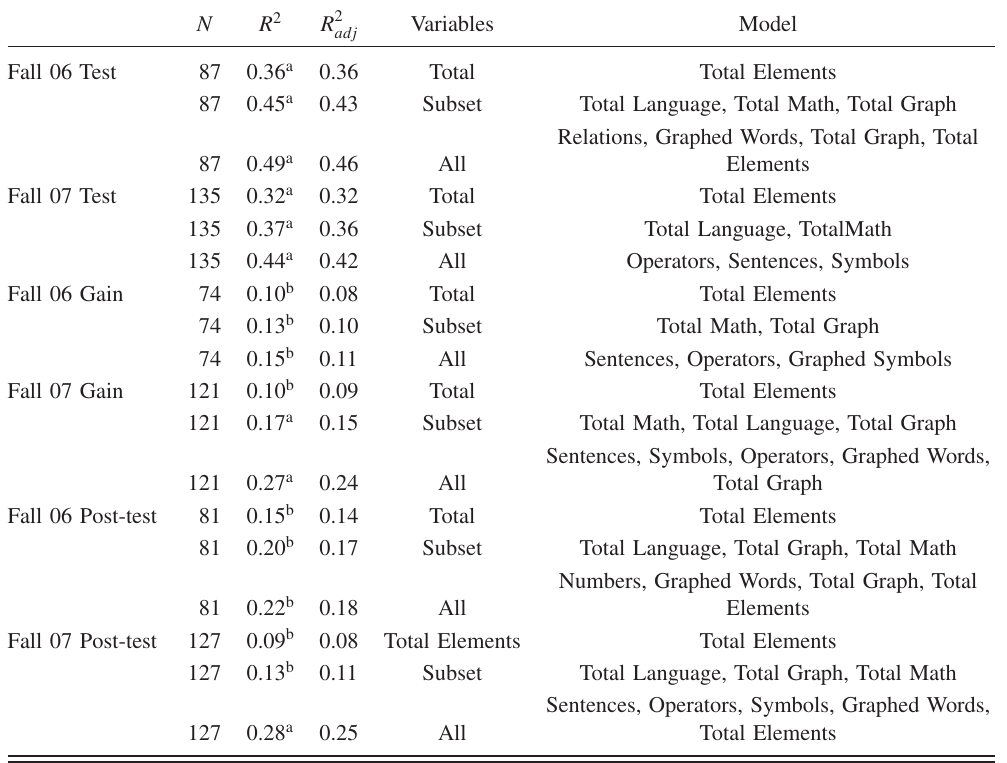
TABLE III. Regression with Standardized Variables—Subset models may contain only the variables Total Language, Total Graph, or Total